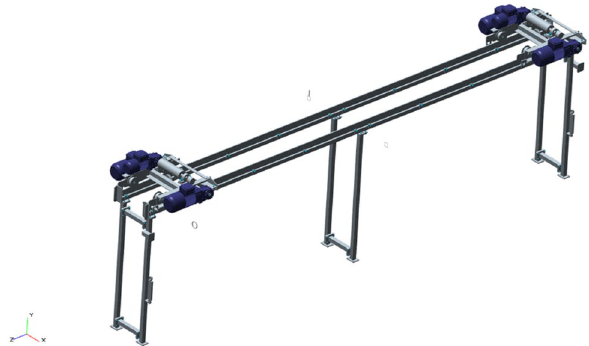
Fig. 3 3D test bench model